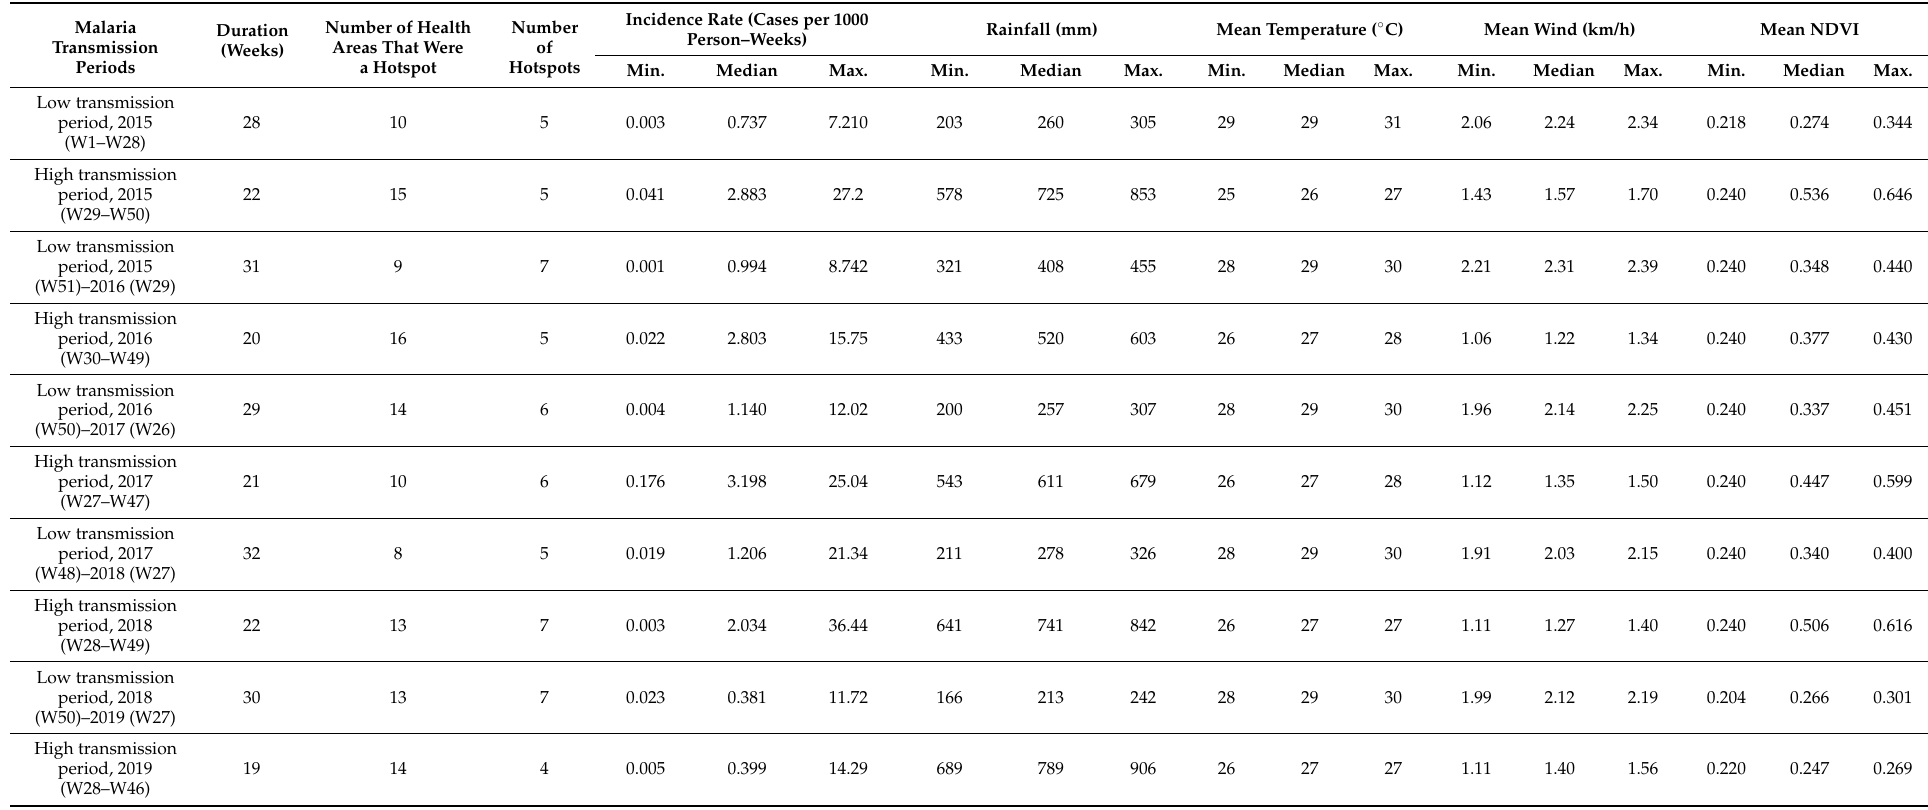
Table 3. Transmission periods according to the presence of hotspots and selected meteorological